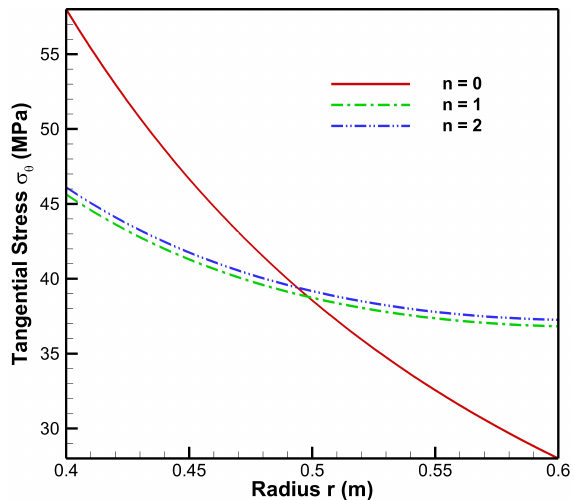
Figure 20. Iterative tangential stress σ θ in FGM cylinder at n = 0, n = 1 and n = 2 iterations under internal pressure, P a = 50 MPa and external pressure, P b = 20